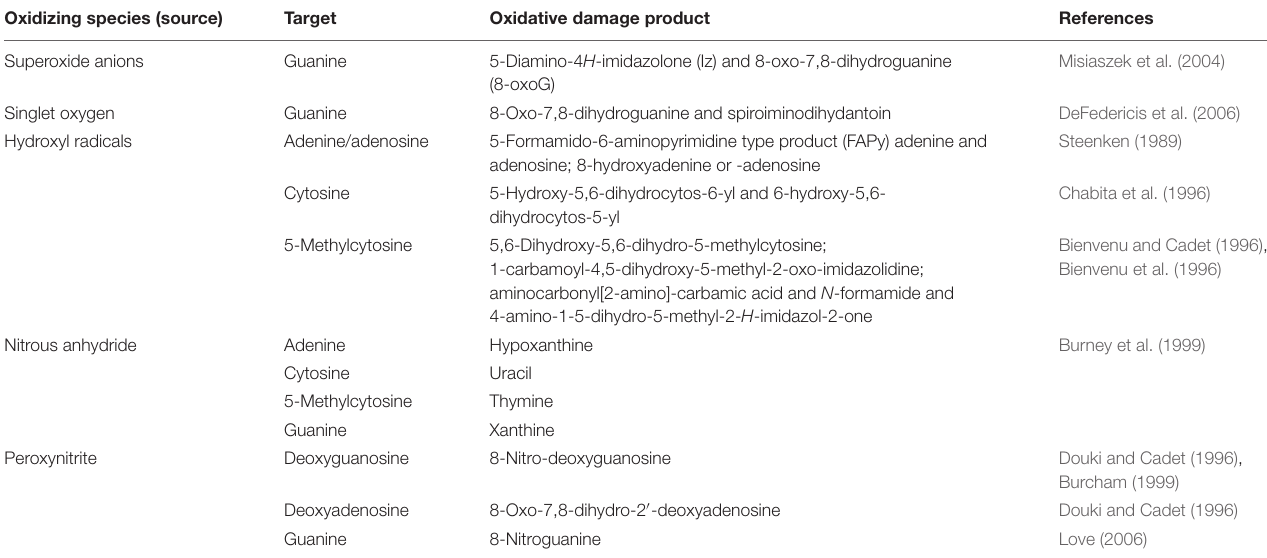
TABLE 1 | Oxidizing species – their targets and